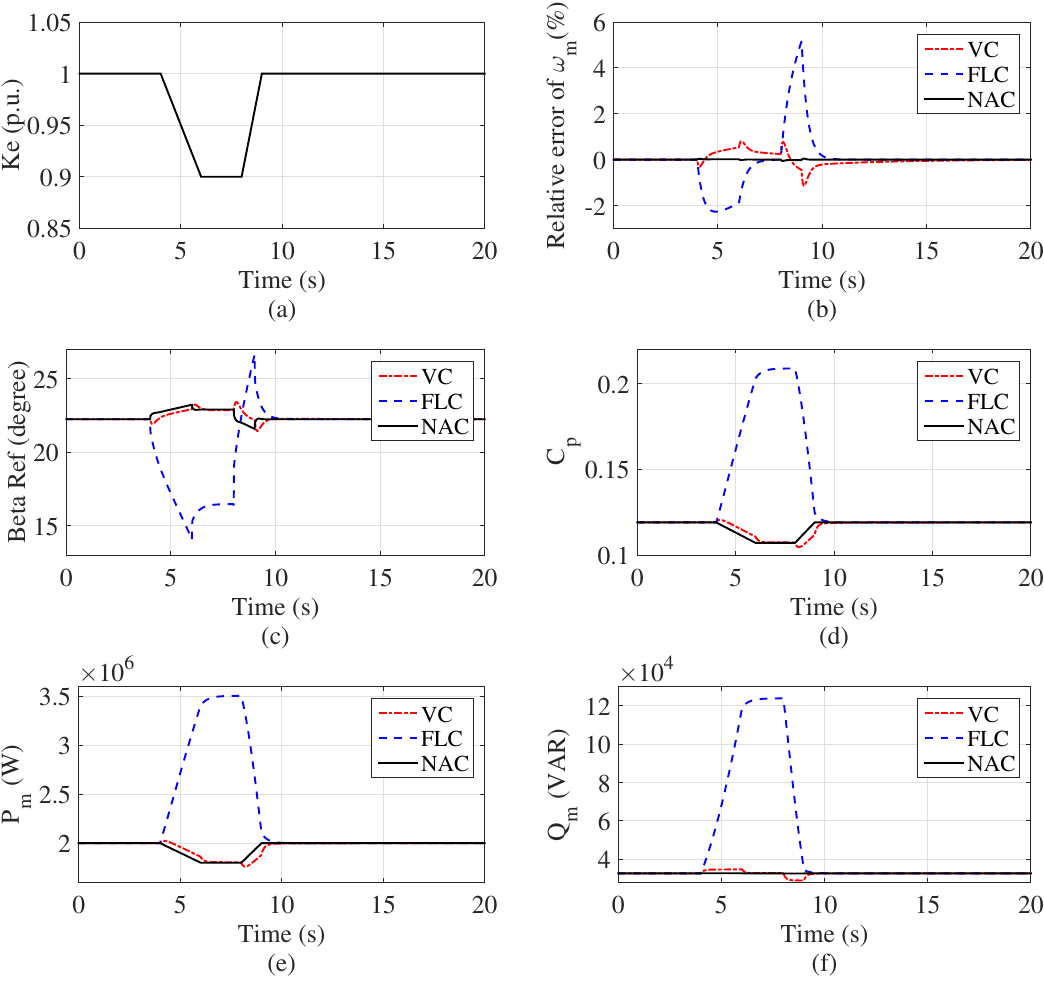
Figure 9. Response to field flux K e variation under constant wind speed. ( a ) Variation of field flux K e . ( b ) Relative error of mechanical rotation speed ω m . ( c ) Required pitch angle. ( d ) Power coefficient C p . ( e ) Active generating power P m . ( f ) Reactive generating power Q m